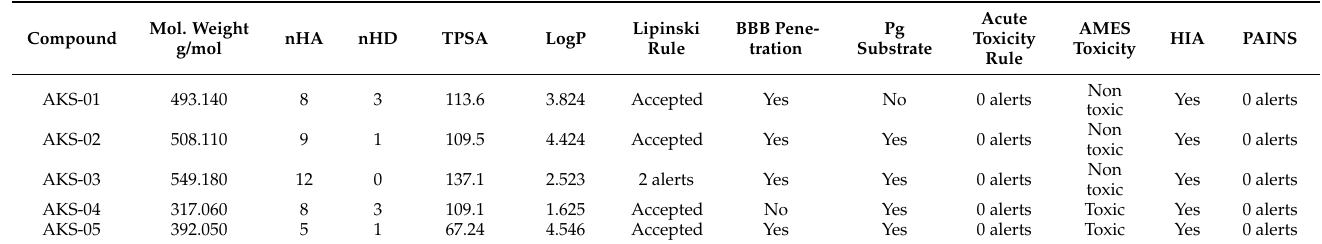
Figure 8. Hydrogen bonds between the interfacial residues of RBD residues and the five selected compounds throughout the 100 ns of simulation. Table 3. In silico predicted physiochemical, pharmacokinetic, toxicity, and cross-reactivities of the five selected virtual